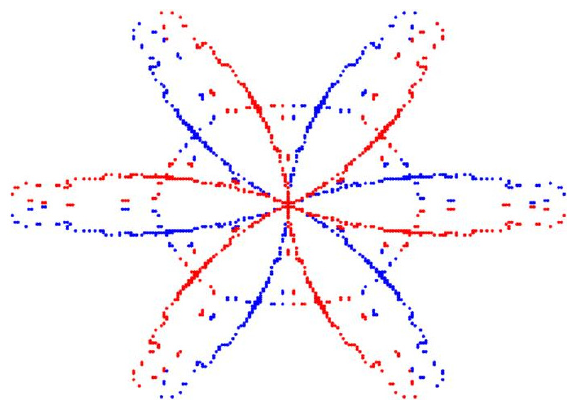
Figure 22. A PV module breakage.